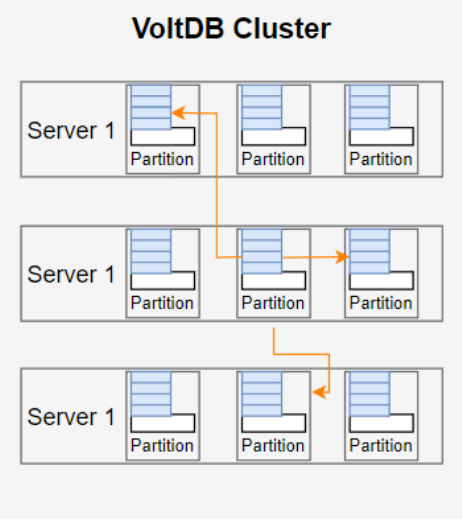
Figure 5. VoltDB architecture components.